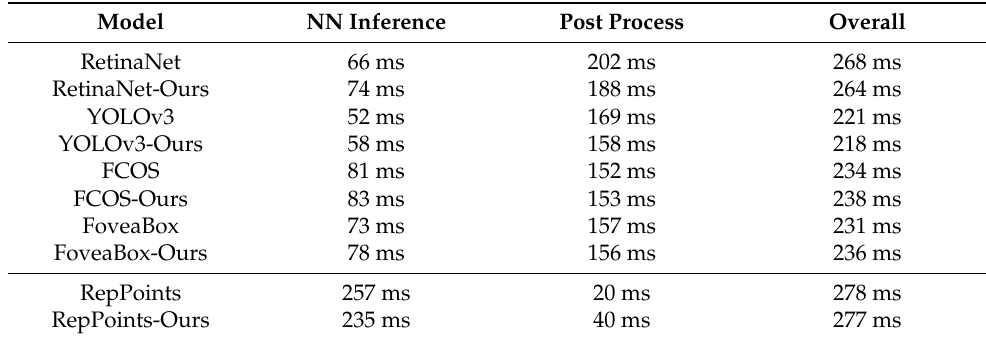
Table 12. Model Inference Time Per Frame of NVIDIA Jetson AGX